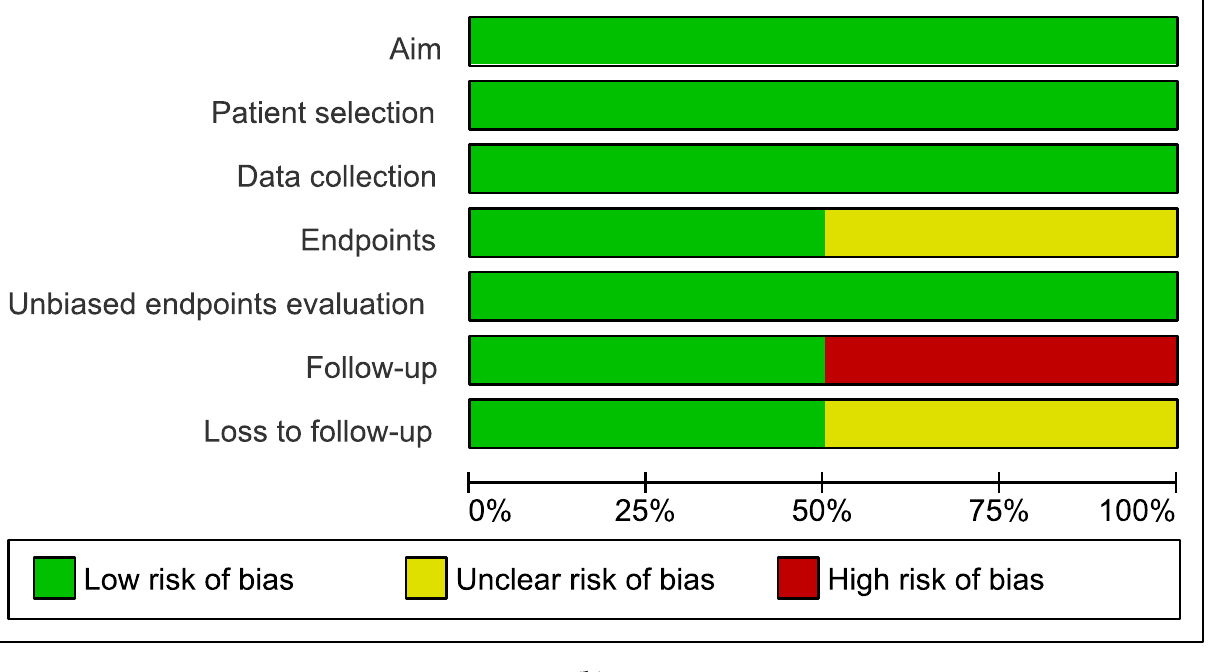
Figure 2. ( a ) Evaluation of the risk of bias within studies. Summary of the risk of bias in individual studies. Plus sign: low risk of bias; minus sign: high risk of bias; question mark: unclear risk of bias. ( b ) Risk of bias graph about risk of bias domains shown as percentages thorough all included studies.